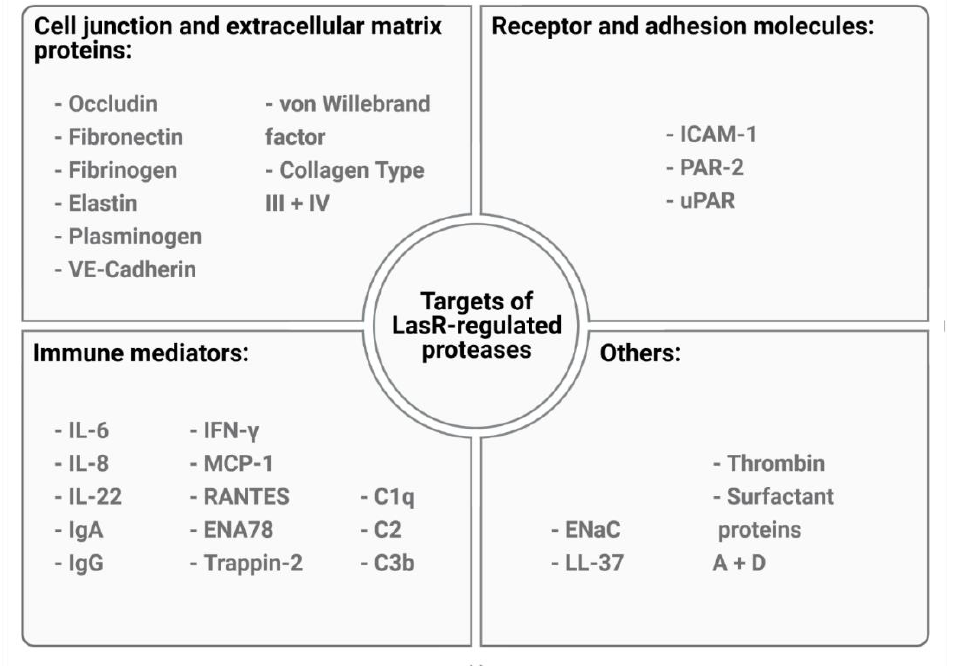
FIGURE 1: Targets of LasR- regulated proteases. LasR- regulated proteases can cleave a large number of host targets ranging from components of the extra- cellular matrix and tight junction to immune medi- ators, adhesion molecules and other molecules. Some targets, such as ICAM-1, can be degraded by multiple LasR-regulated proteases, while others such as ENaC are proteo- lytically activated rather than